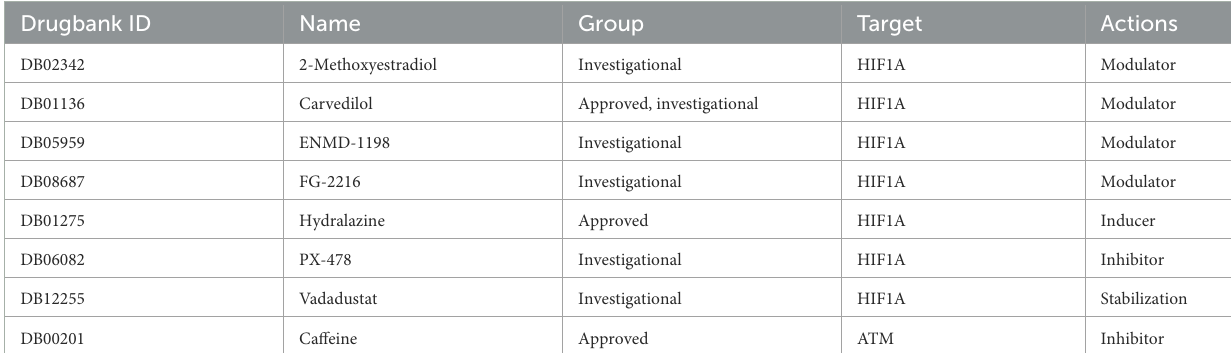
TABLE 2 Drugs obtained from the DrugBank database targeting the hub genes.